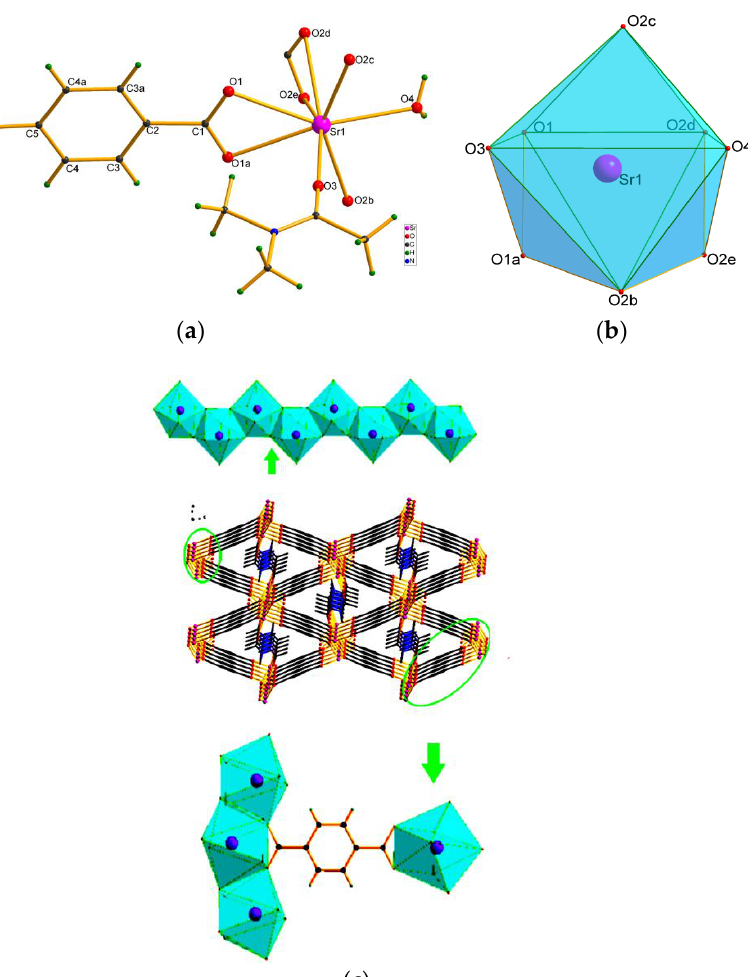
Figure 1. ( a ) Asymmetric unit of Sr-MOF. ( b ) Coordination mode of the Sr 2+ ion. Atoms marked with